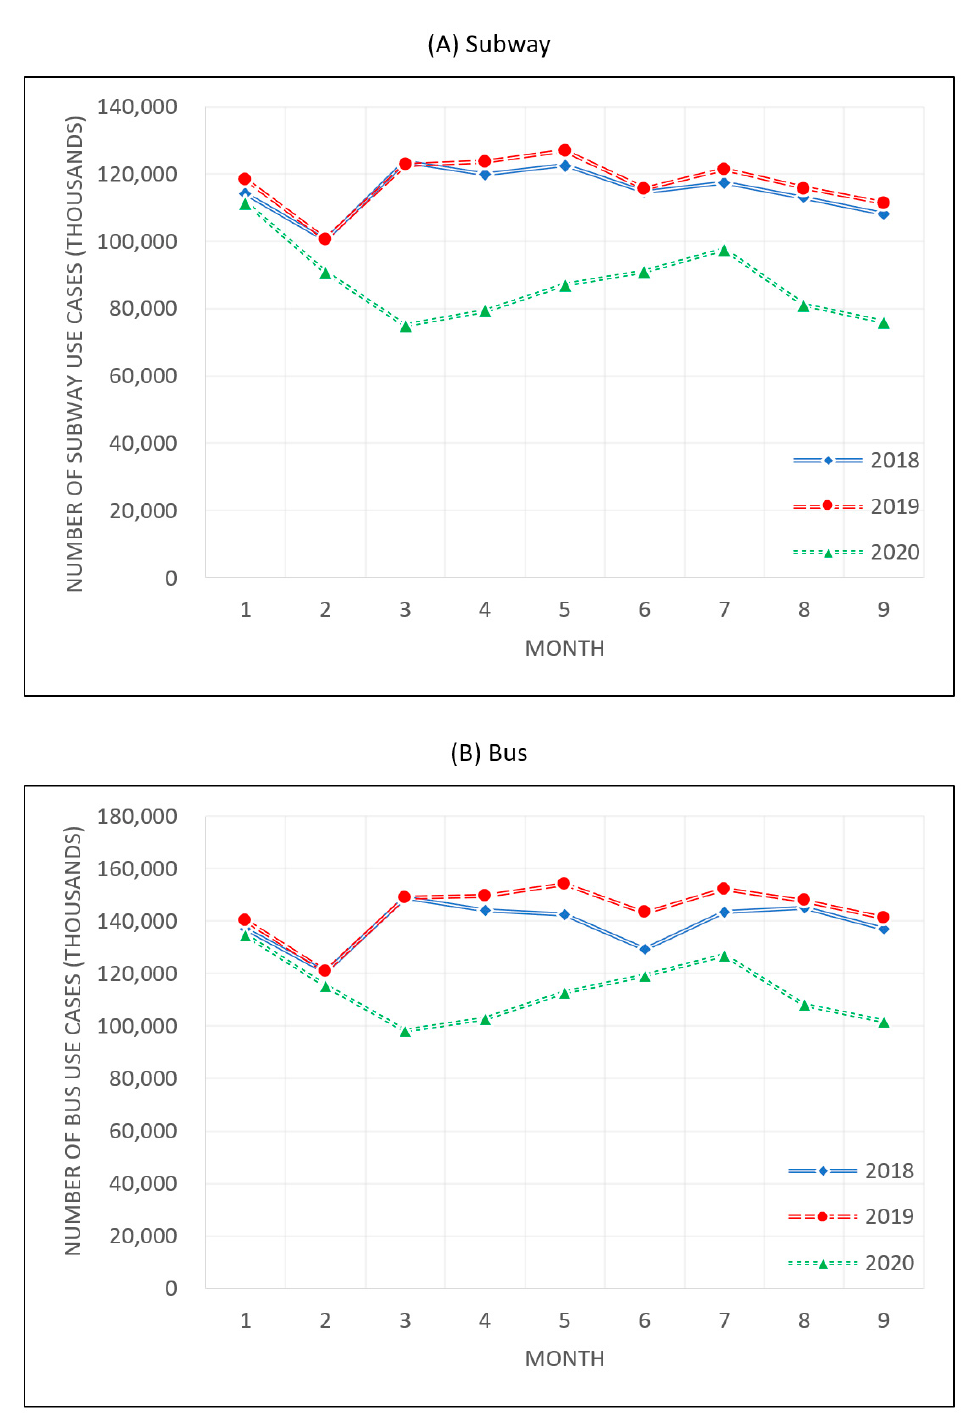
Figure 2. Number of uses of mass transit during